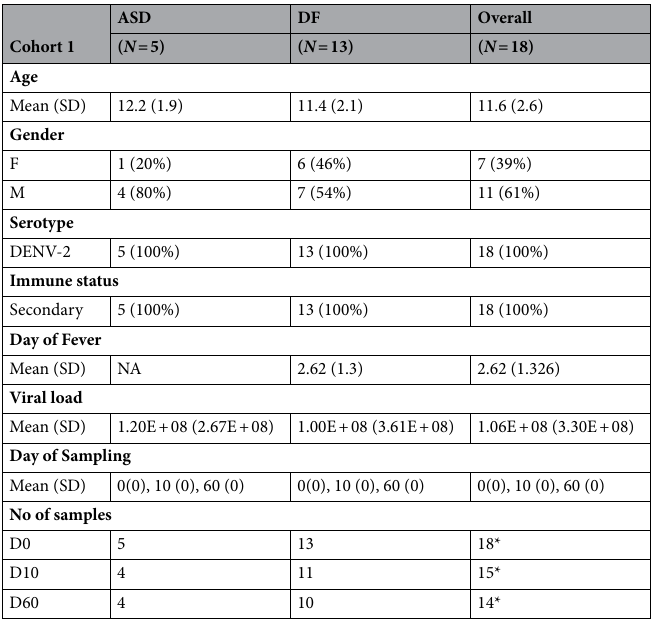
Table 1. Demographic and clinical characteristics of cohort 1. NA: not applicable. *Among those, there are 12 paired-plasma samples across D0,D10 and D60.